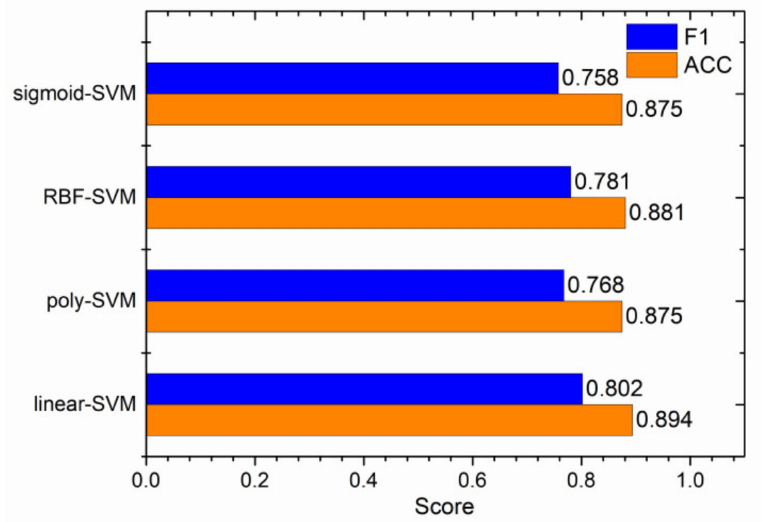
Figure 6. Classification performances of linear-SVM, poly-SVM, RBF-SVM, and sigmoid-SVM.